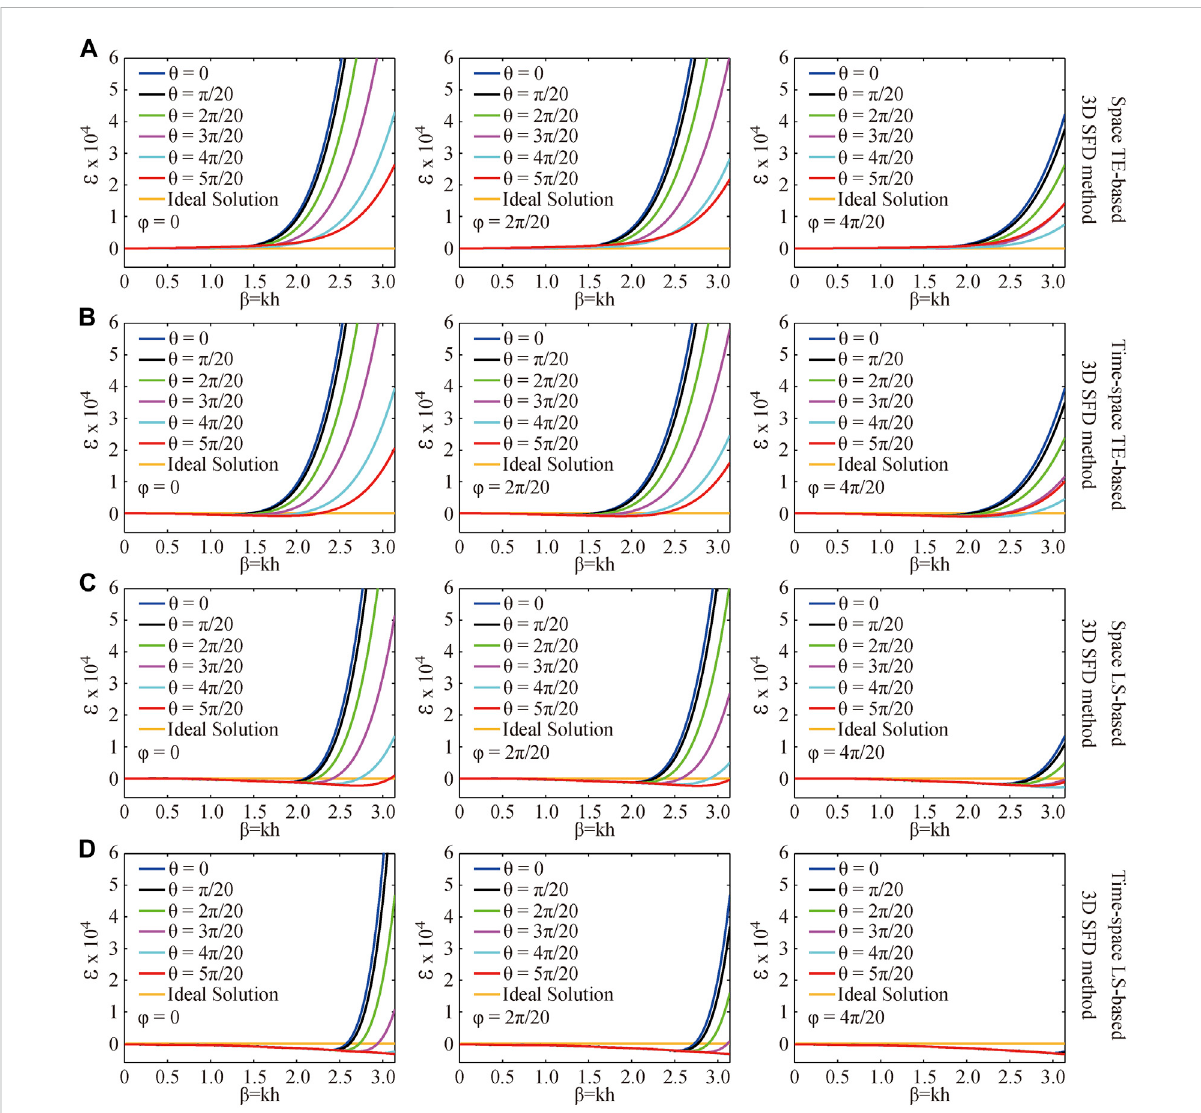
FIGURE 2 Variation curves of numerical dispersion ( ε ) with the propagation angle ( θ ) and azimuth angle ( φ ) changing for the simple 3D homogeneous acoustic model (Model A). These subgraphs (A – D) indicate different 3D SFD methods listed in